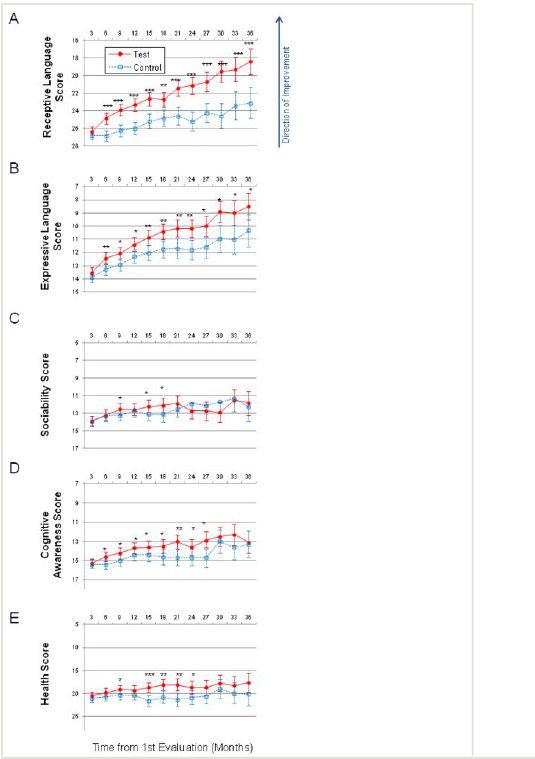
Longitudinal plots of subscale scores LS Means. Horizontal axis shows months from the 1st evaluation (0 to 36 months). Error bars set at 95% confidence interval. To facilitate comparison between subscales, all vertical axes ranges have been normalised to show 35% of their corresponding subscale’s maximum available score. A lower score indicates symptoms improvement. P-value is marked: ***< 0.0001; **< 0.001; *< 0.05. (A) Receptive Language score. (B) Expressive Language score. (C) Sociability score. (D) Cognitive awareness score. (E) Health score. The test group included study participants who completed more than one thousand PFS exercises and made no more than one error per exercise. The control group was selected from the rest of participants by a matching procedure. Each test group participant was matched to the control group participant by age, gender, expressive language, receptive language, sociability, cognitive awareness and health score at 1 evaluation using propensity score analysis. The complete methods and the discussion of results can be found in Vyshedskiy et al. 2020b, from which the figure (which is available under a